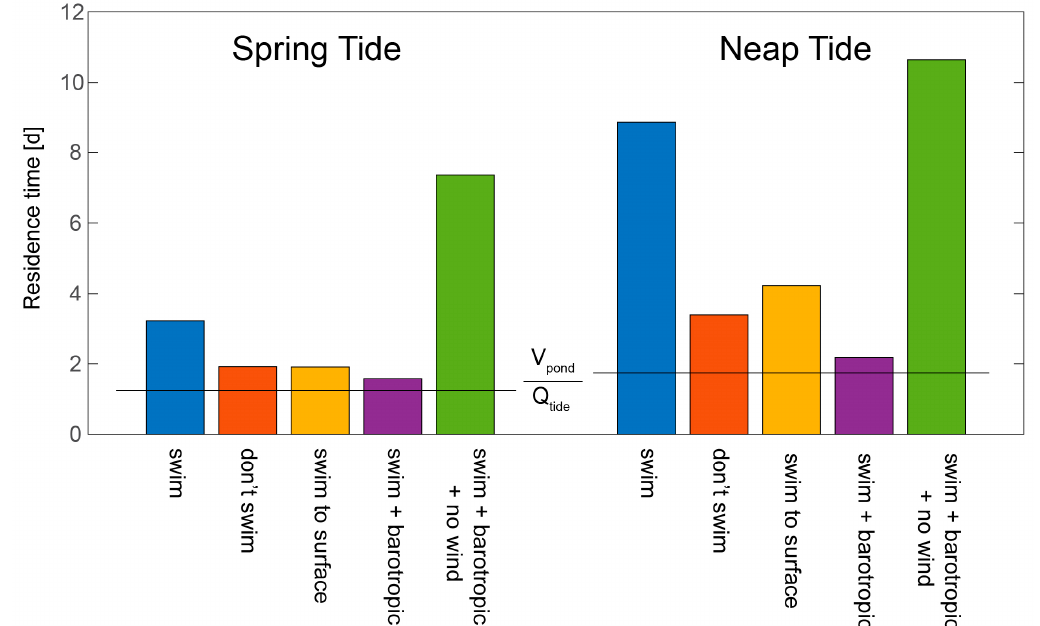
Figure 25. Computed residence times for the toxic alga A. fundyense based on the 3D model of Ralston et al. [127] for a pond within the Nauset Estuary (Massachusetts, USA). The different bars represent a variety of swimming and forcing cases under spring and neap tide conditions. “Swim”: diel vertical migration up to 1/ k w depth, where k w is the light attenuation coefficient. “Don’t swim”: no vertical migration. “Swim to surface”: diel migration to the surface. “Swim + barotropic”: diel vertical migration to 1/ k w with barotropic physics (uniform water density and thus no stratification). “Swim + barotropic + no wind”: diel vertical migration to 1/ k w with barotropic physics and zero wind forcing. Horizontal lines: the residence time for tidal exchange assuming a well-mixed pond (volume of pond/tidal volume exchange), shown for reference. (Redrawn from Ralston et al. [127] with the permission of D. Ralston).